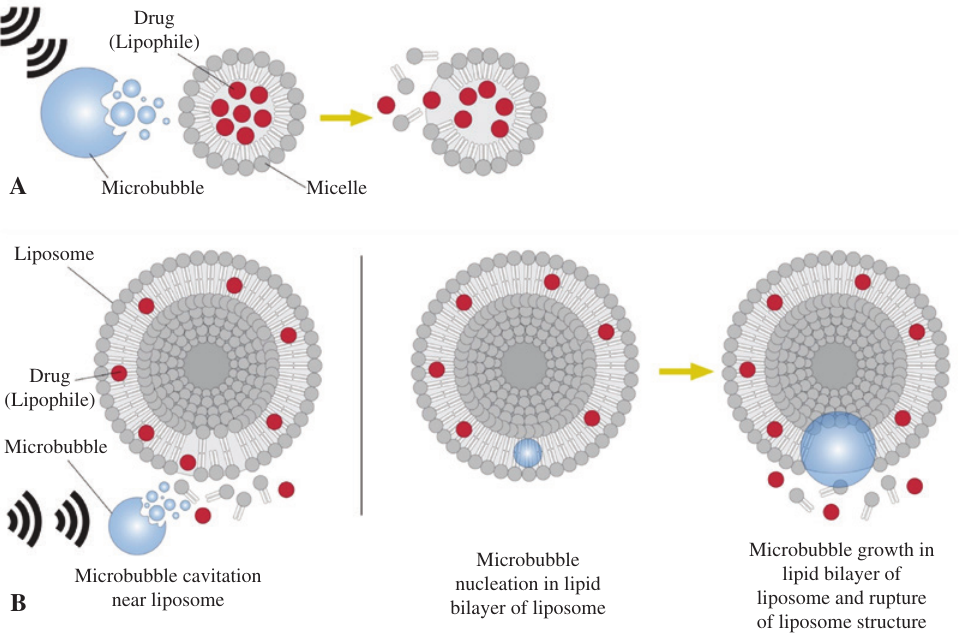
Figure 10: Proposed mechanism for (A) cavitation effect on micelle rupture, (B) liposome collapse.